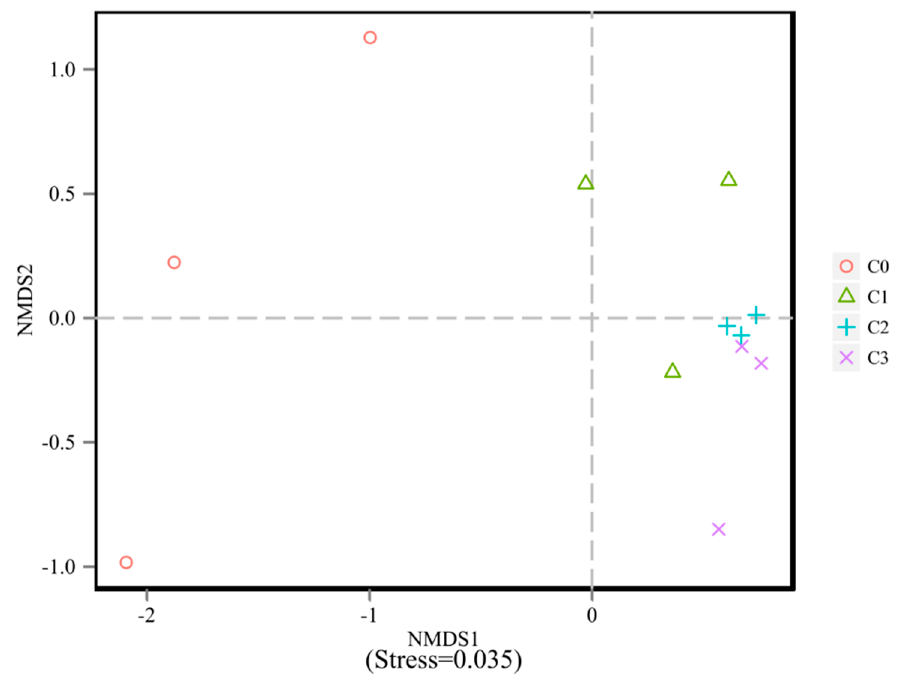
Figure 3. Non-metric multidimensional scaling (NMDS) ordination of bacterial community in response to biochar addition.